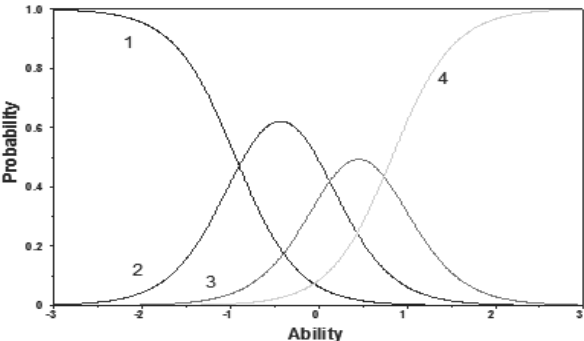
Figure 1 – Category response curves for item 5, 1st